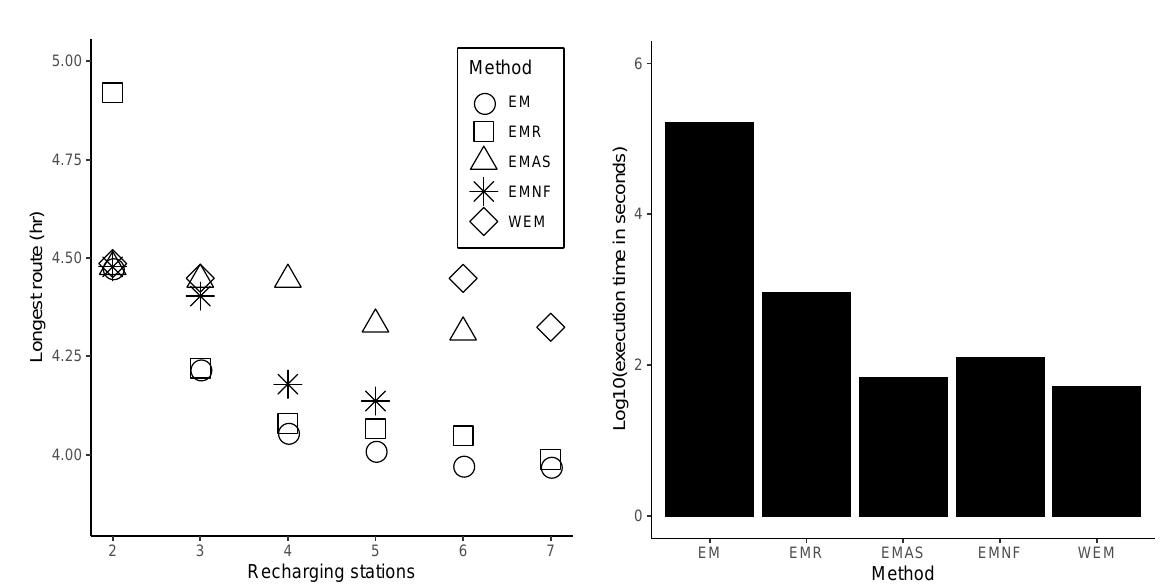
( b ) Logarithmic scale of the time to compute the fronts. Figure 10. Results for a type D instance with 20 targets and 3